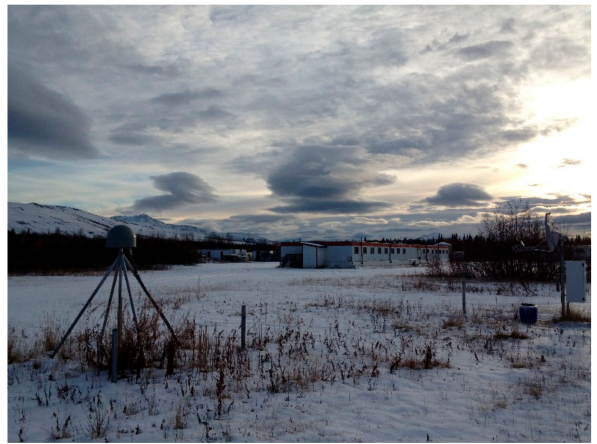
Figure 6. Site photo from AB33, located in Coldfoot,